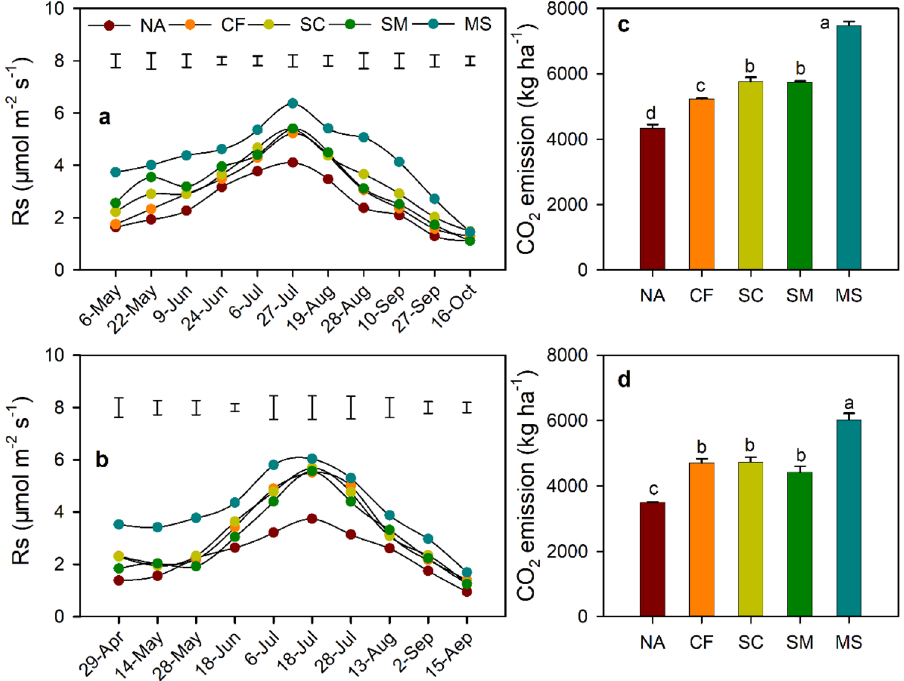
Figure 2. Soil respiration (Rs) and CO 2 emission in 2020 ( a and c ) and 2021 ( b and d ) under different treatments. NA, no fertilizer; CF, inorganic fertilizer; SC, inorganic fertilizer plus organic fertilizer; SM, organic fertilizer; MS, maize straw. Bars in figure ( a and b ) represent LSD values ( p < 0.05). Different letters in figure ( c and d ) indicate significant difference at p <